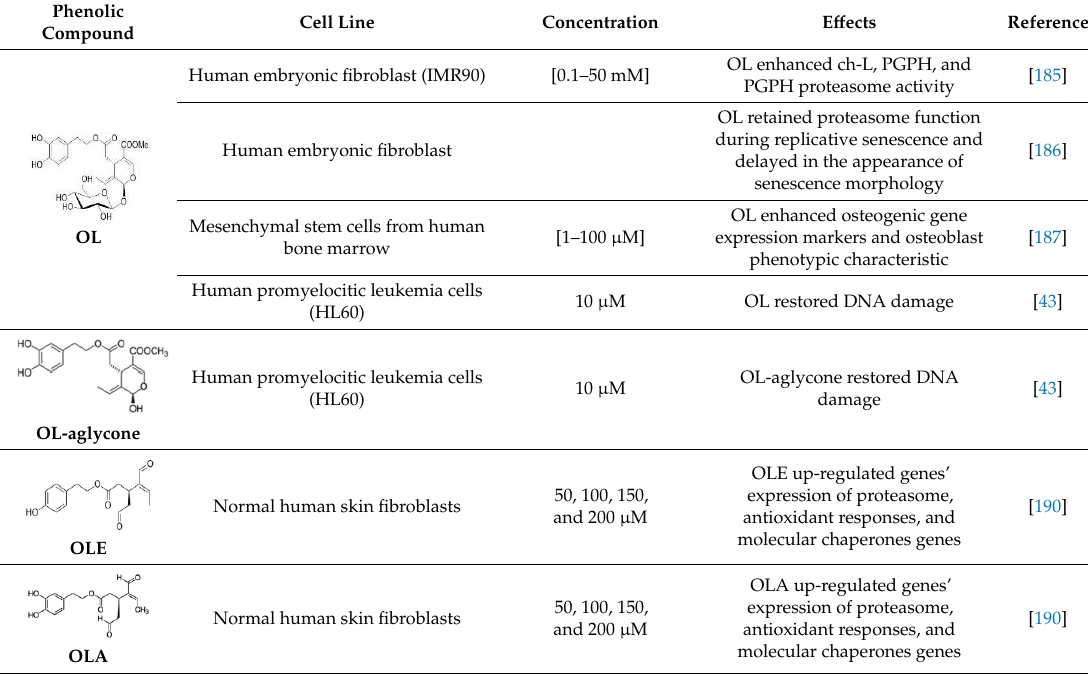
Table 8. Potential role of secoiridoids obtained from the olive tree in anti-aging processes: in vivo studies.